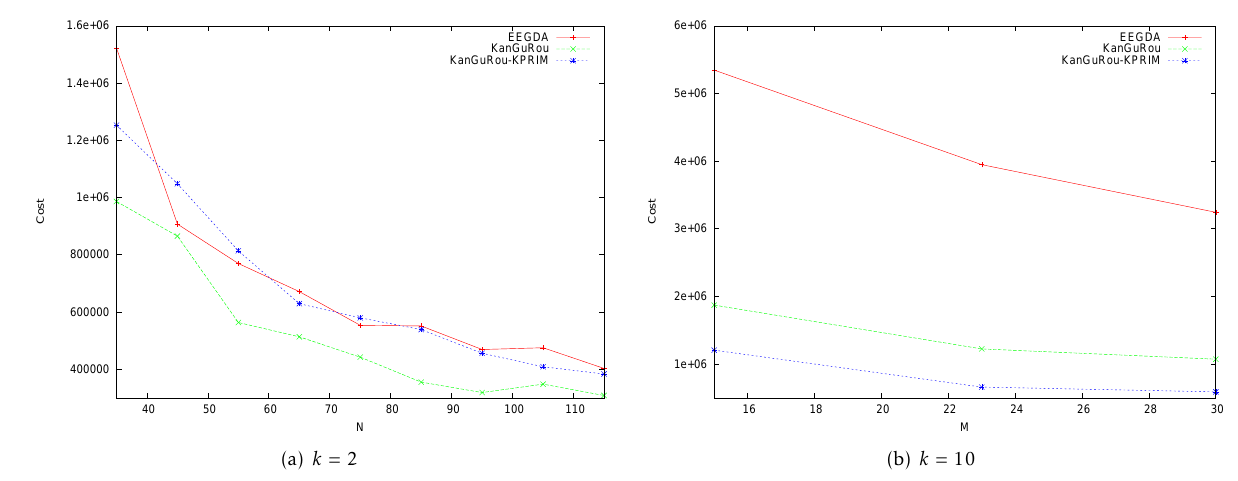
Figure 8. Algorithms performances for M = 20 sinks and N = 75 nodes.